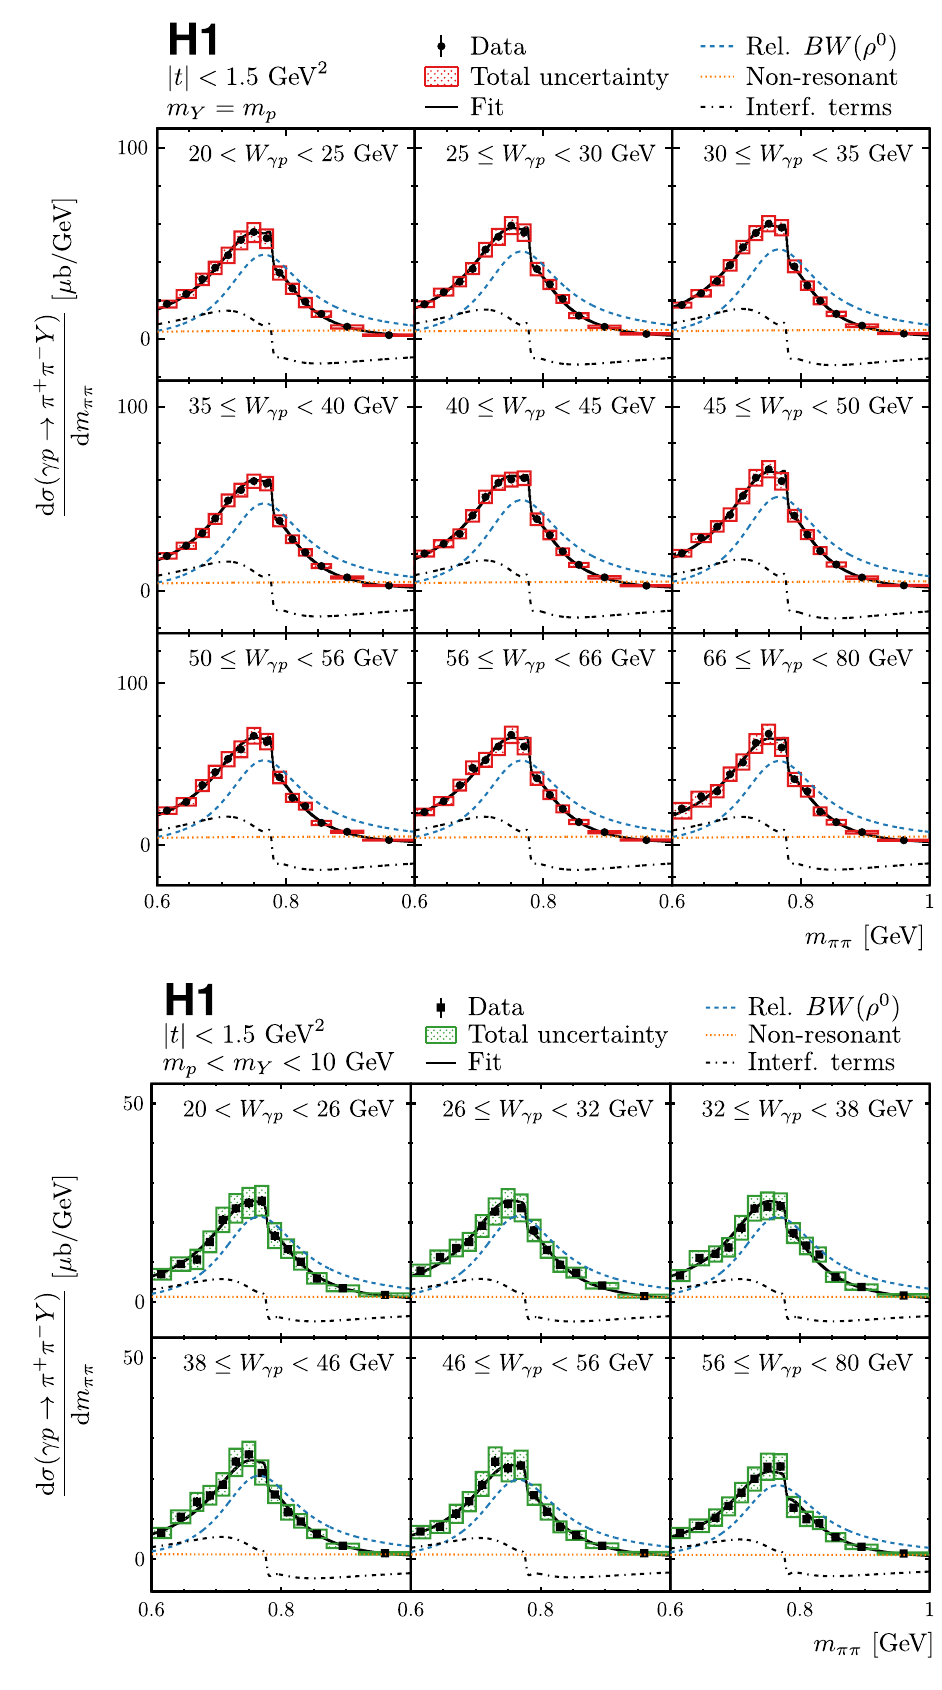
Fig. 8 Elastic ( m Y = m p ) differential π + π − photoproduction cross sections d σ(γ p → π + π − p )/ d m ππ in bins of W γ p and as functions of m ππ . The model that is fitted to the data as described in the text and its components are also shown